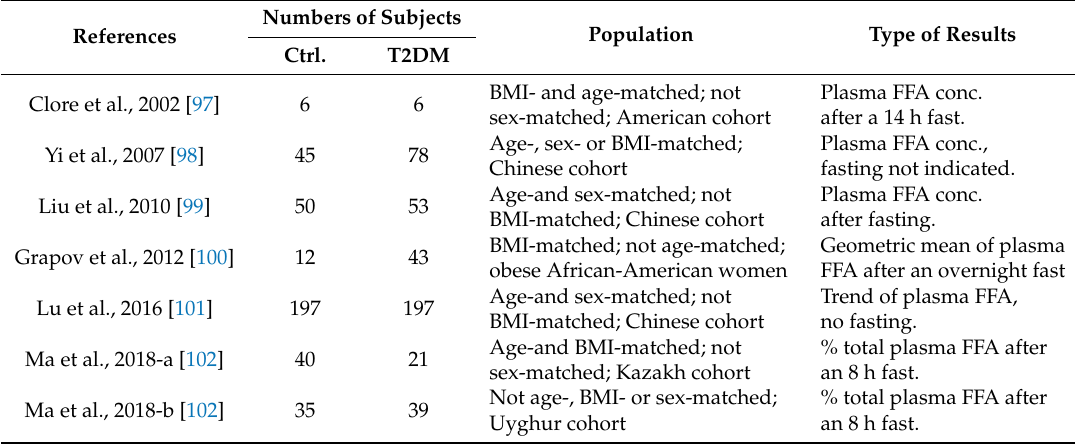
Table 1. Studies having measured the concentrations of individual FFA species in the blood from subjects with T2DM and controls and characteristics of the populations